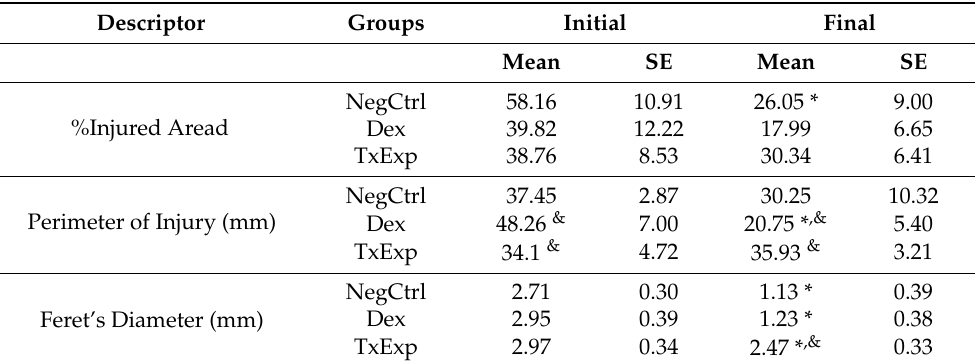
Table 1. Wound size